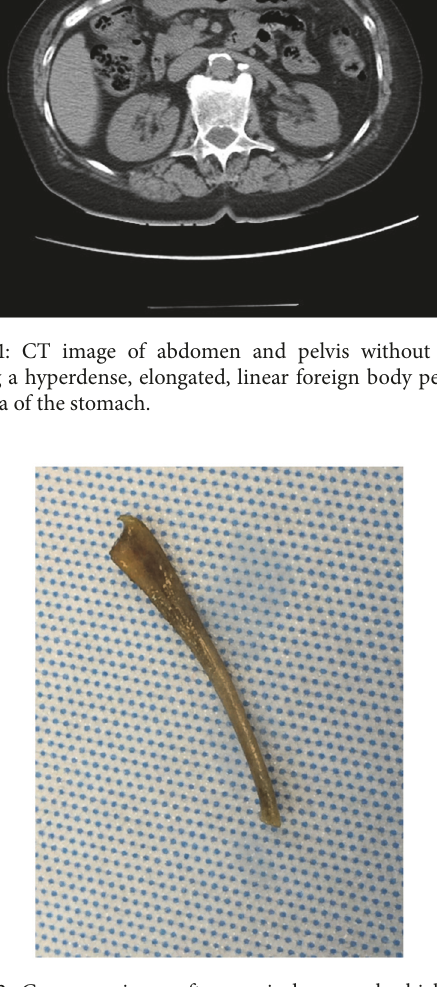
Figure 2: Gross specimen after surgical removal, chicken bone measuring approximately 3 cm in length by 2 mm in